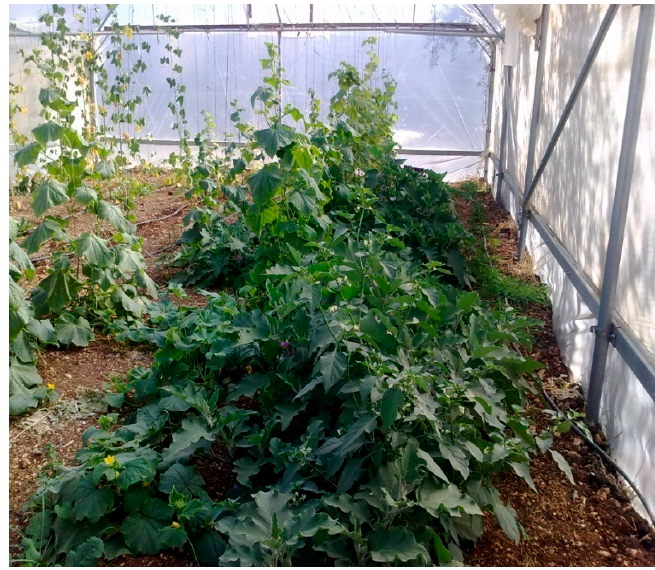
Figure 2. Reuse scheme by treated grey water in Palestine, Al Qubeba-Jerusalem.